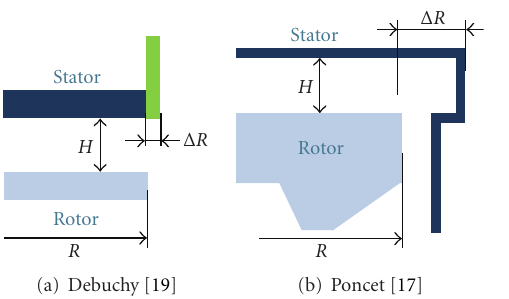
Figure 2: Schema of the peripheral inlet